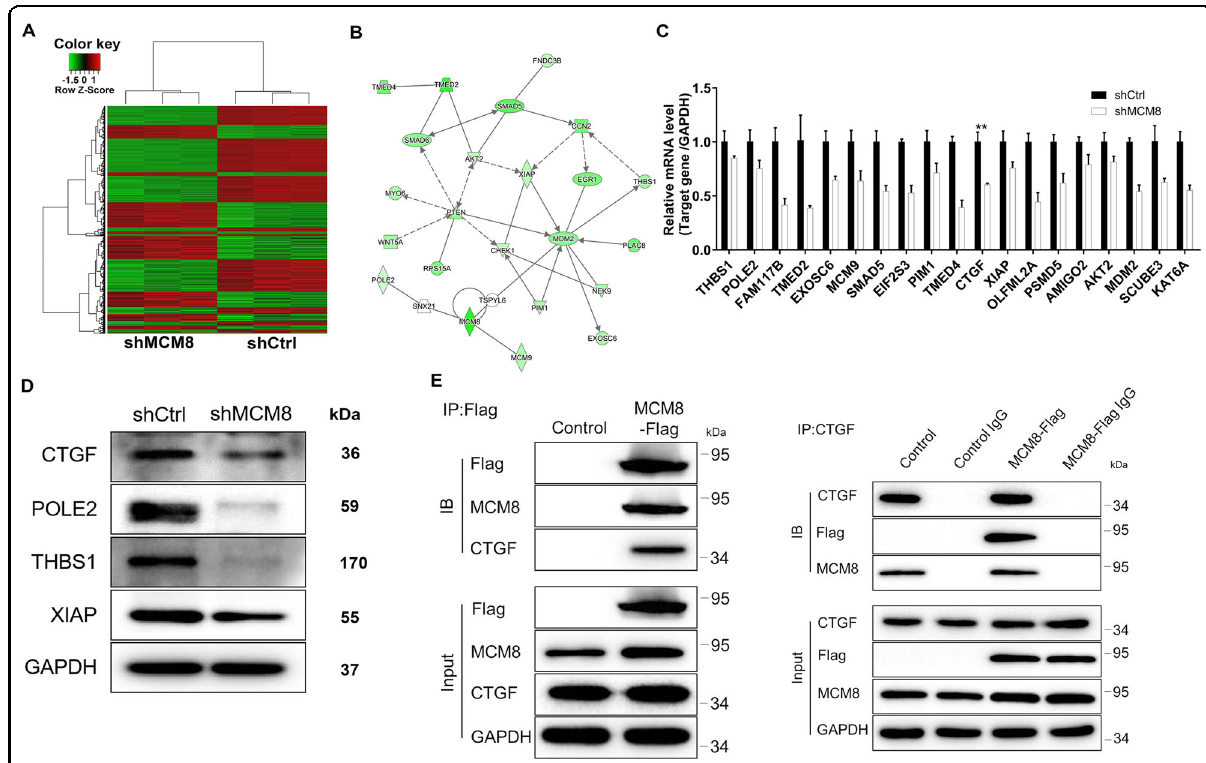
Fig. 4 Exploration of underlying mechanism by GeneChip and IPA analysis. A The heatmap of DEGs identi fi ed by RNA-sequencing of cells treated with shCtrl ( n = 3) or shMCM8 ( n = 3). B Interaction network diagram between DEGs was analyzed by IPA. The expression of several most signi fi cantly differentially expressed genes identi fi ed by qRT-PCR ( C ) and western blot ( D ) in MNNG/HOS cells with shMCM8. E Co-IP assay was used to verify whether there was protein interaction between MCM8 and CTGF. Control: MNNG/HOS cells transfected with negative control lentivirus. MCM8-Flag: MNNG/HOS cells transfected with Flag tagged MCM8 overexpression lentivirus. The data are expressed as mean ± SD ( n ≥